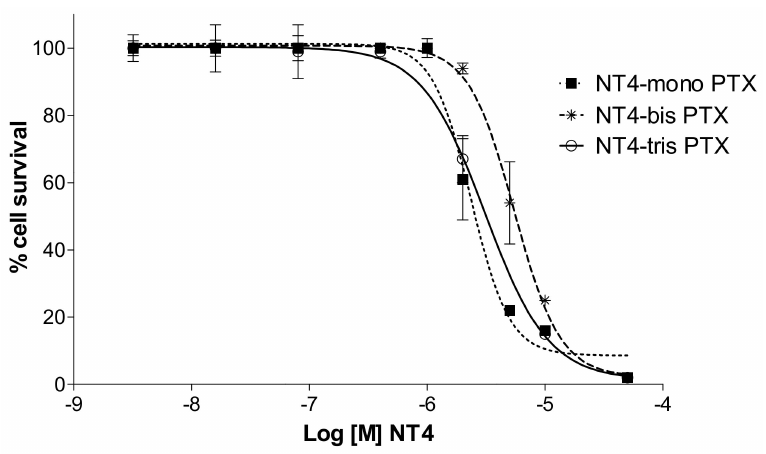
Figure 2. Cytotoxicity of NT4-mono PTX, NT4-bis PTX, and NT4-tris PTX in HT-29 cell